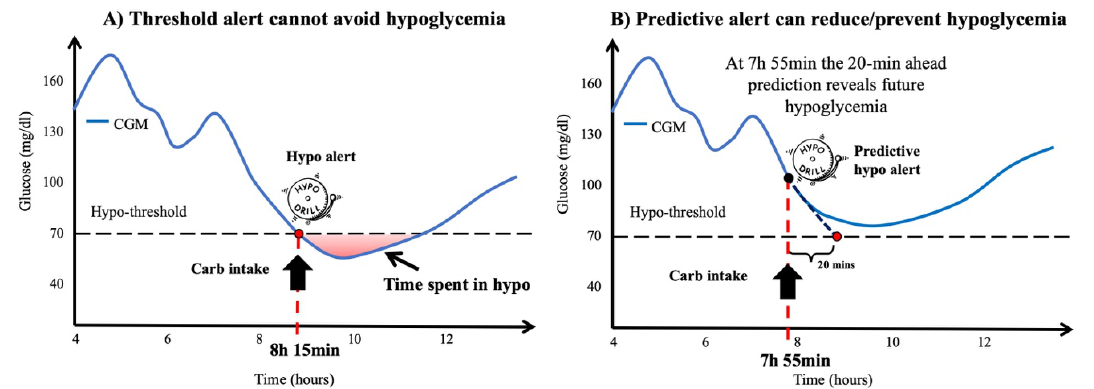
Figure 4. Representative example to illustrate the efficacy of a predictive hypoglycemia alert. ( A ) Imaginary CGM profile of a patient using standard threshold-crossing alerts. A hypo alert is generated at time 8:15 when CGM crosses the hypoglycemia threshold. Even if this patient takes some carbs in response to the alert, the patient spends some time in hypoglycemia. ( B ) Example of how a low predictive alert can help to avoid hypoglycemic events. In this example, the alert is generated at 7:55, when the 20-min ahead glucose prediction crosses the hypoglycemia threshold. If the patient takes carbs in response to the predictive alert, it will be possible to prevent the